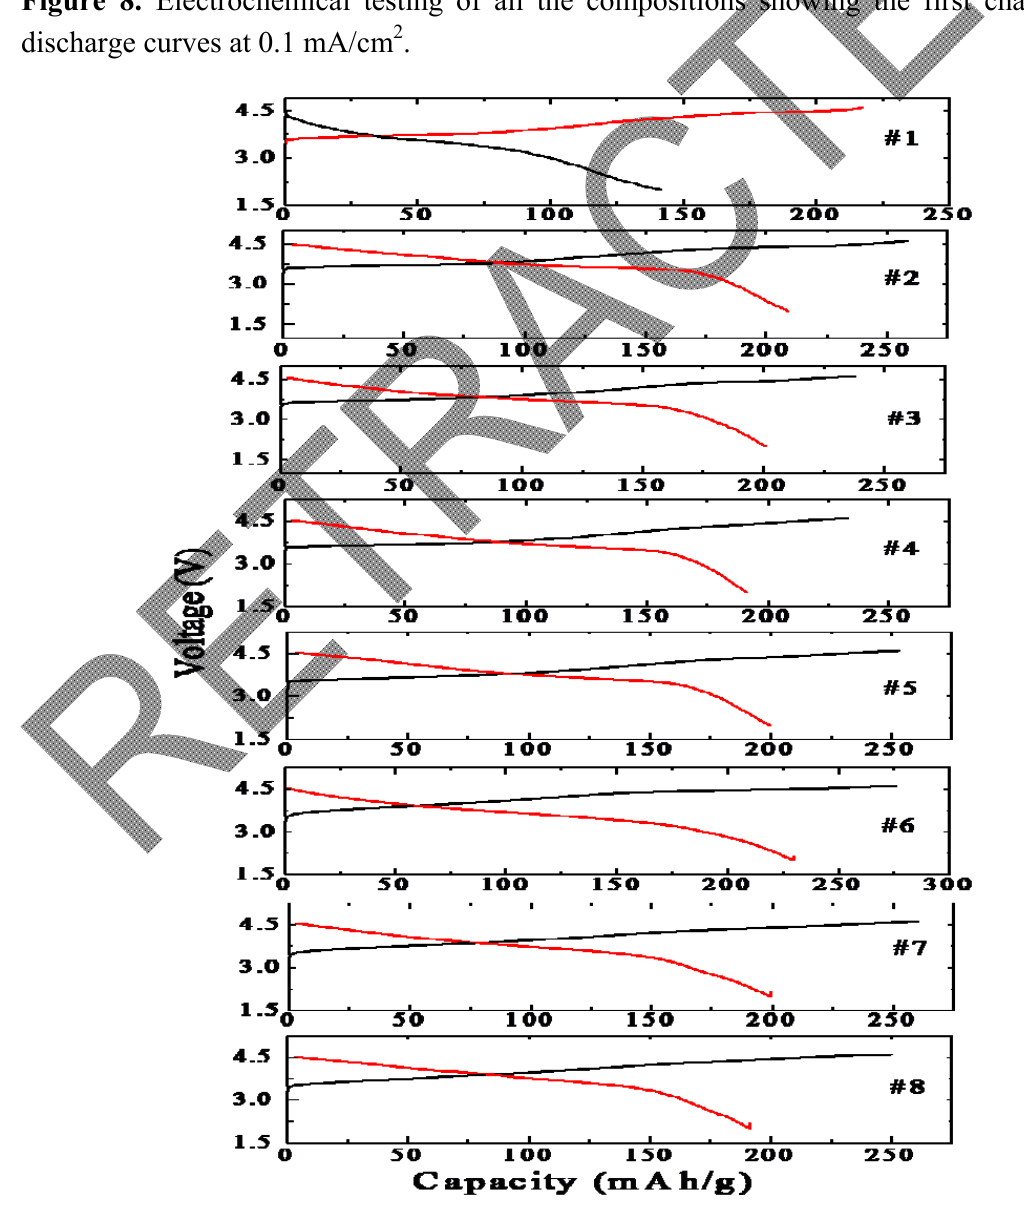
Figure 8. Electrochemical testing of all the compositions showing the first charge and discharge curves at 0.1 mA/cm 2